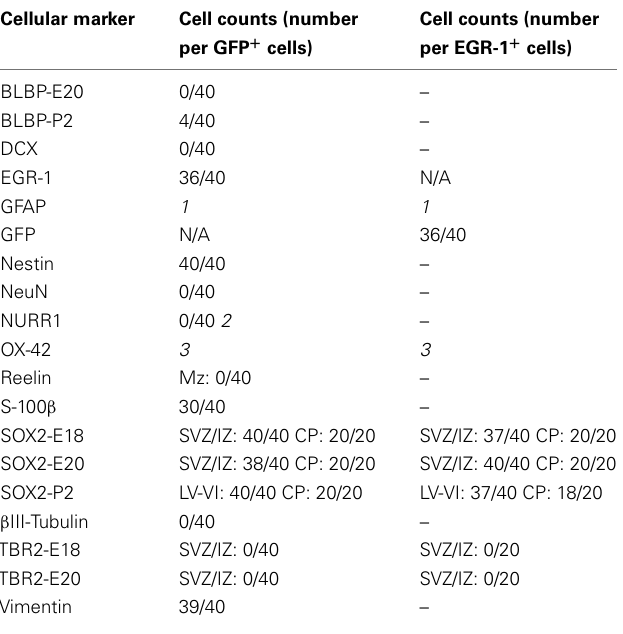
− 633 and − 9 relative to TSS in the rat promoter sequence).